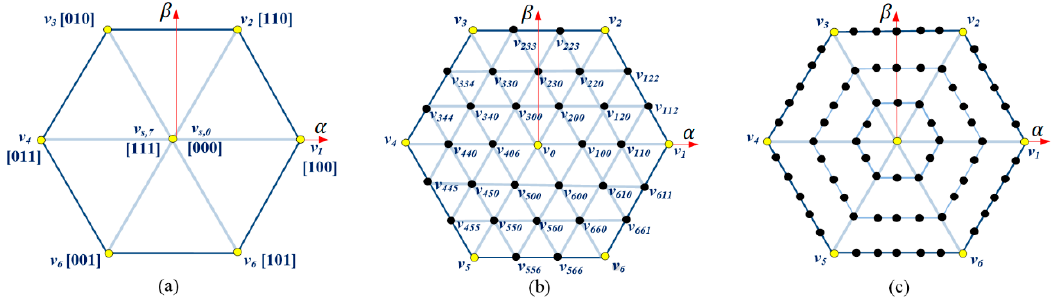
Figure 1. Space voltage vector (VV) diagram with ( a ) real VVs, ( b ) synthesized VVs using (11), and ( c ) synthesized VVs using (13).